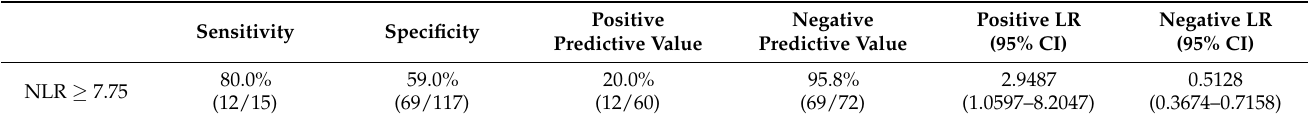
Table 2. Diagnostic indices, predictive values, and likelihood ratios of maternal NLR (neutrophil to lymphocyte ratio) ≥ 7.75 within 48 h before delivery for the identification of amnionitis in cases with either preterm labor and intact membranes (PTL) or preterm premature rupture of membranes (preterm-PROM) (The prevalence of amnionitis is 11.4%